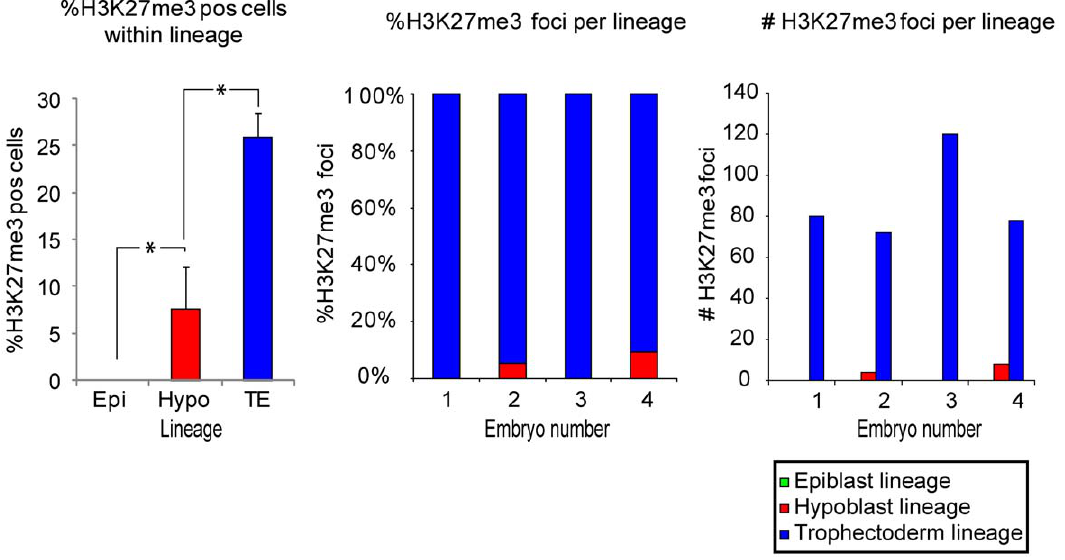
Figure 6. Degree of H3K27me3 foci per lineage. The percentages of cells in each lineage that carry a distinct H3K27me3 focus in embryos that have been co-cultured with decidualized endometrial cells for 72 h. Left panel: relative number of H3K27me3 per lineage as a function of the total number of cells within that lineage; middle panel: absolute values of H3K27me3 foci counted within each lineage for each embryo; right panel: relative number of H3K27me3 foci in each lineage as a function of the total number of foci observed in that embryo. H3K27me3 foci did not reveal any preferential distribution within the embryo. Green: H3K27me3 foci in OCT4 positive epiblast precursors; red: H3K27me3 foci in GATA4 positive hypoblast precursors; blue: H3K27me3 foci in OCT4- and GATA4- negative trophectoderm cells. Asterisks denote significant differences: *p , 0.05. Epi=Epiblast lineage; Hypo=Hypoblast lineage; TE=Trophectoderm lineage.